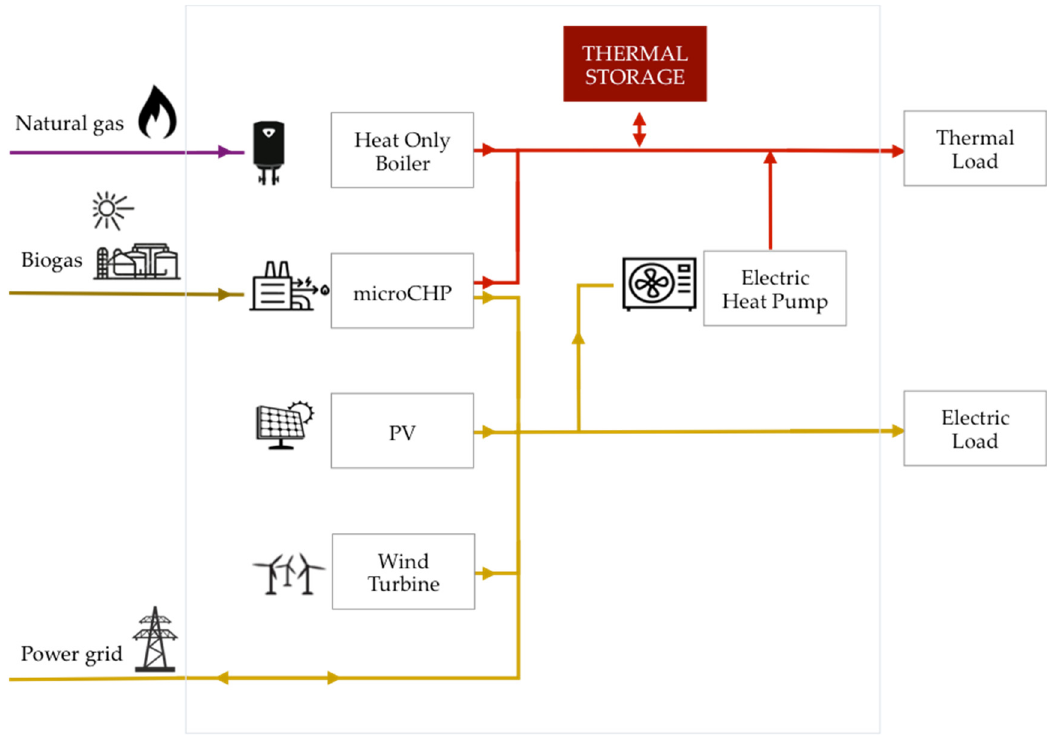
Figure 6. System layout Case 1.